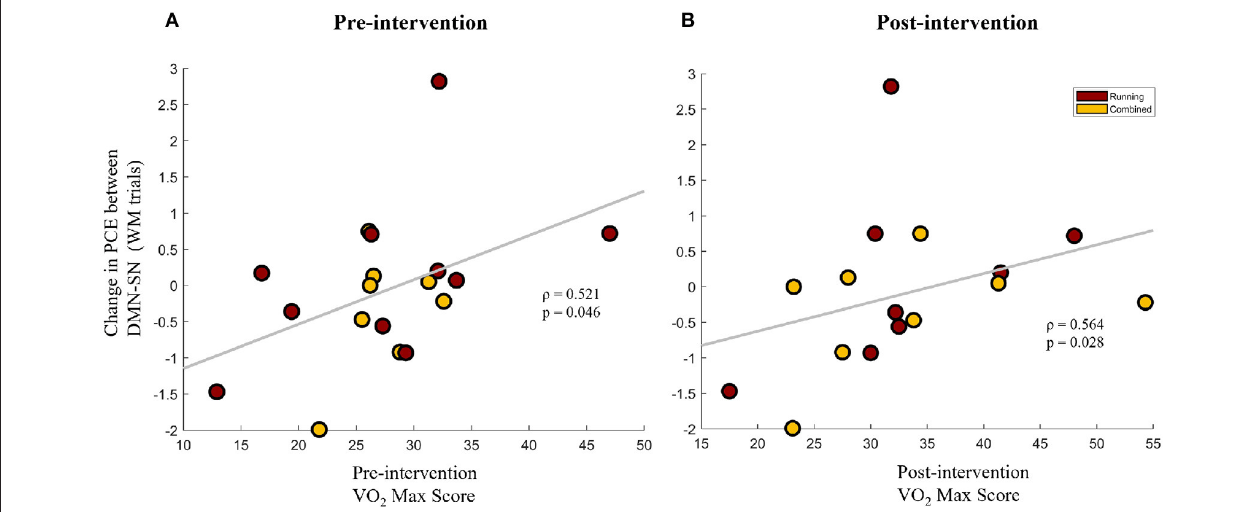
FIGURE 5 | The change in pairwise cross-entropy (PCE) between the DMN and SN networks during WM trials (a lower PCE value indicates higher DMN-SN synchronization) for the participants that participated in the aerobic exercise protocol (Running group + Combined group). Change in PCE is shown against the VO2-Max scores of the participants at the pre-intervention timepoint (A) and the post-intervention timepoint (B) .